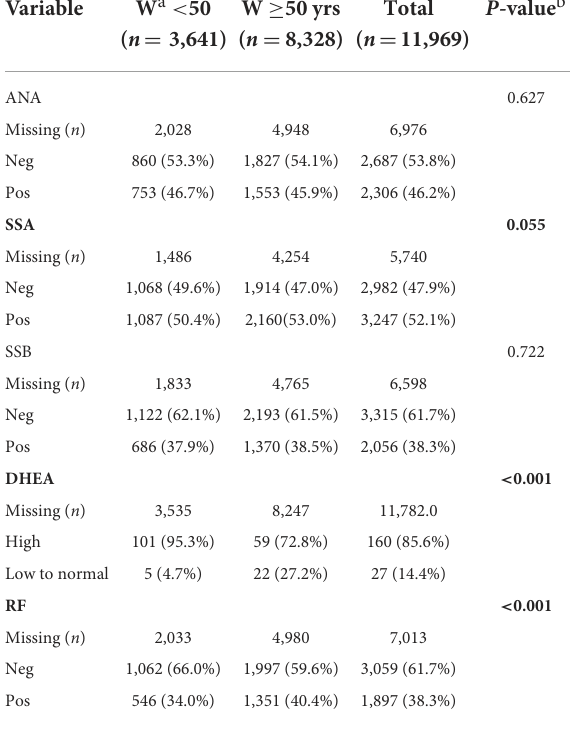
TABLE 5 Autoantibodies and DHEA in female Sjögren’s disease patients by age.